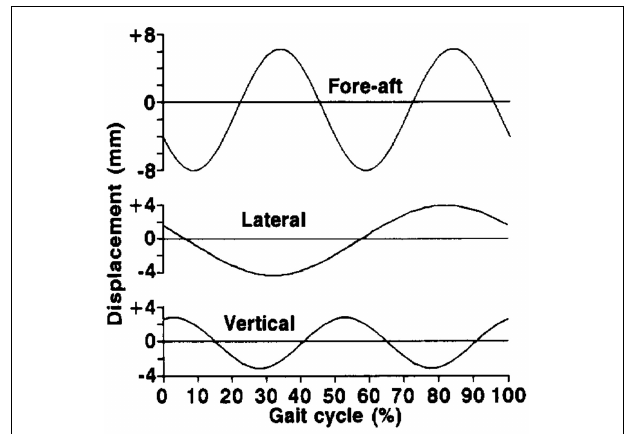
FIGURE 12 | Biomechanics measurements of CoM displacement (Whittle,